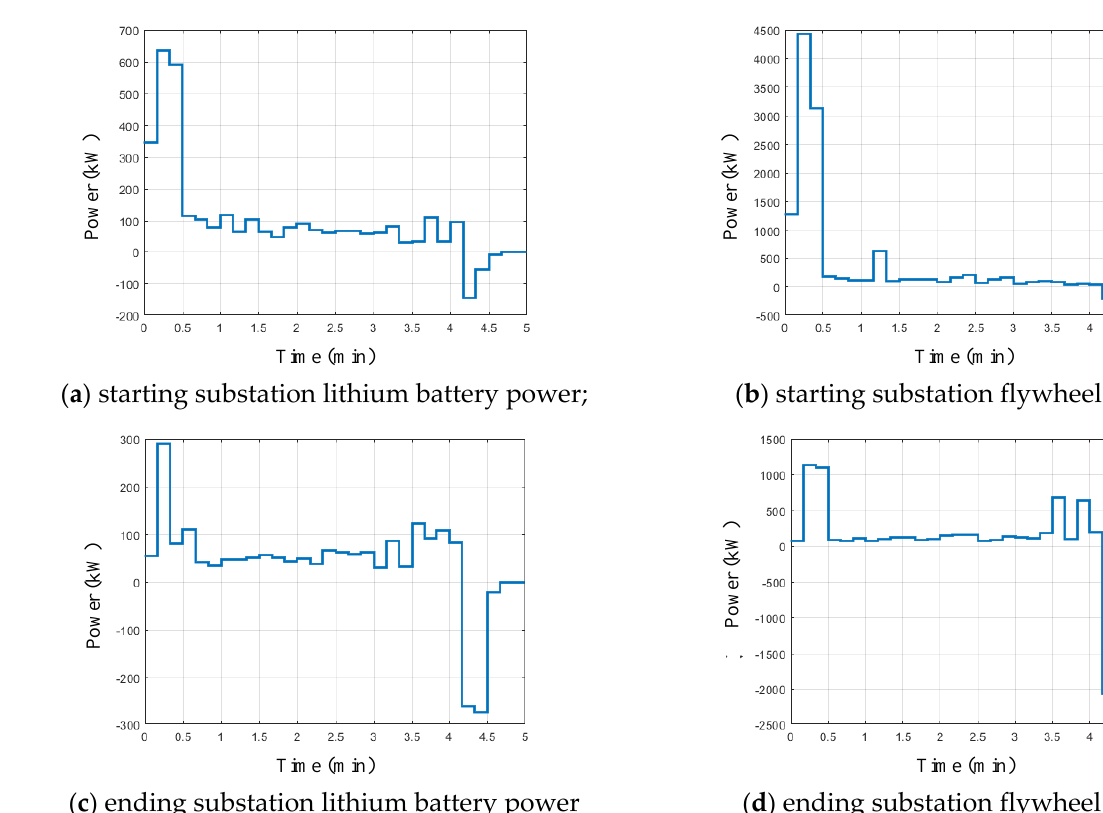
Figure 13. Energy storage power sequence.